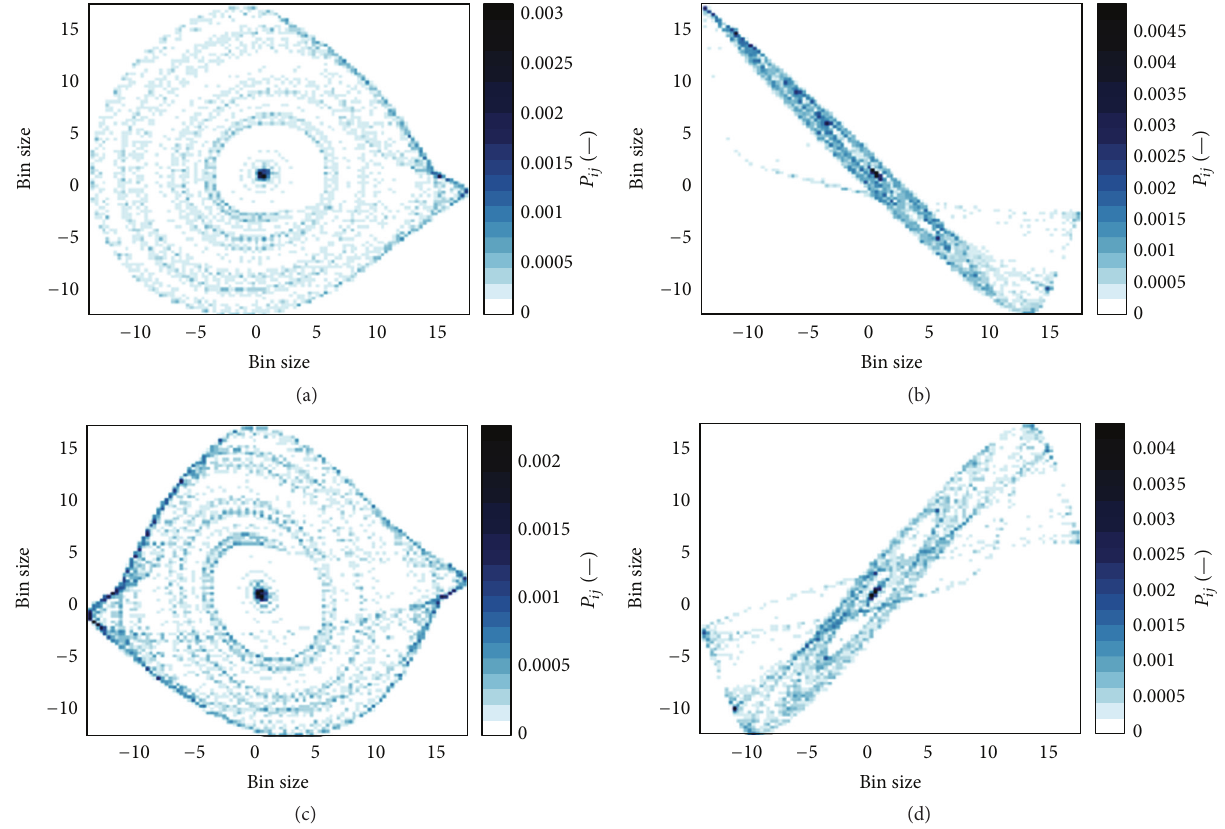
Figure 4: Probability phase space cuts for the Lorenz model: (a) 𝜏 = MIF min ; (b) 𝜏 = 2 MIF min ; (c) 𝜏 = 3 MIF min ; (d) 𝜏 = 4 MIF min .